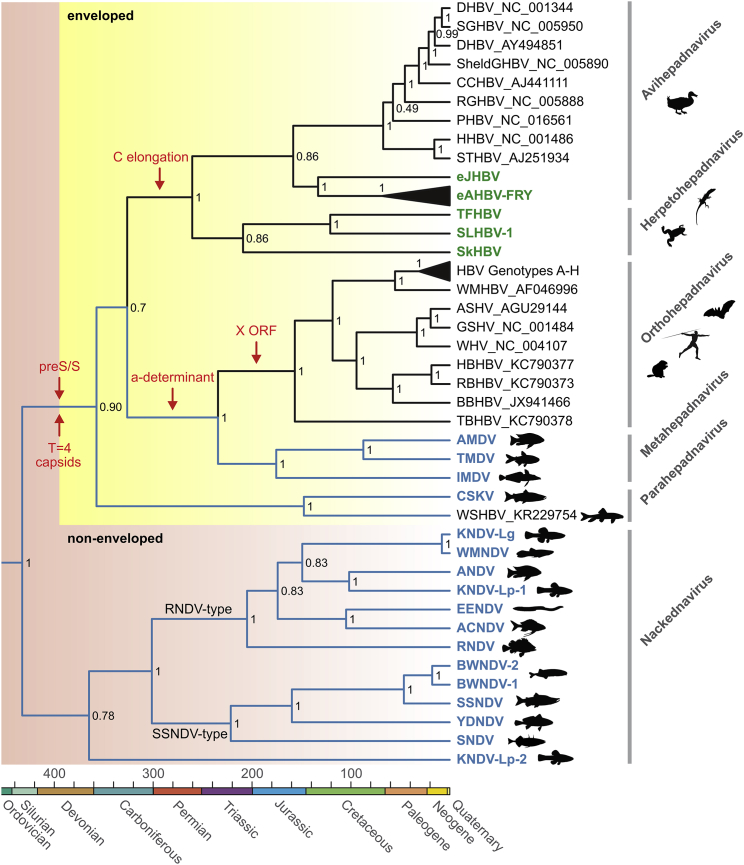
Phylogenetic Relationship of Hepadna- and NackednavirusesRooted Bayesian phylogenetic tree based on protein sequence alignments of conserved regions in the TP, RT, and RH domains of P (437 amino acid positions). For details on parameter optimization of the Bayesian phylogenetic model, see the STAR Methods. Viruses discovered in this study are in color; lineages with piscine hosts in blue. A fourth member of the metahepadnavirus clade was described in a study by Dill et al. (2016). Scale bar, millions of years. Numbers at branching points: posterior probability support values. Red arrows: most parsimonious periods of major evolutionary innovations. The X ORF is an evolutionary novelty of orthohepadnaviruses.See also Figures S4, S5, and S7 and Tables S2 and S3.